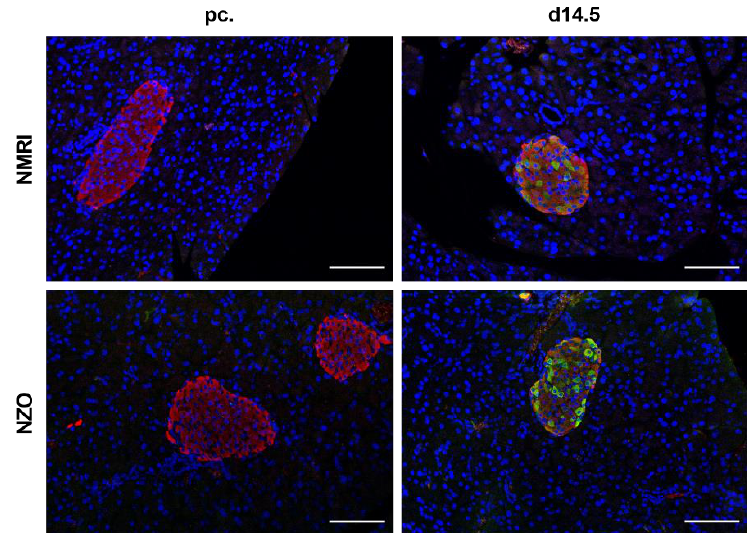
Figure 2. Co-localization of insulin and 5-HT in islets of Langerhans during gestation. Representative images of a double immunofluorescence staining for insulin (red) and 5-HT (green) at time points preconceptional and d14.5 of gestation. Nuclei were stained with DAPI (blue). Scale bars, 100 µ m.